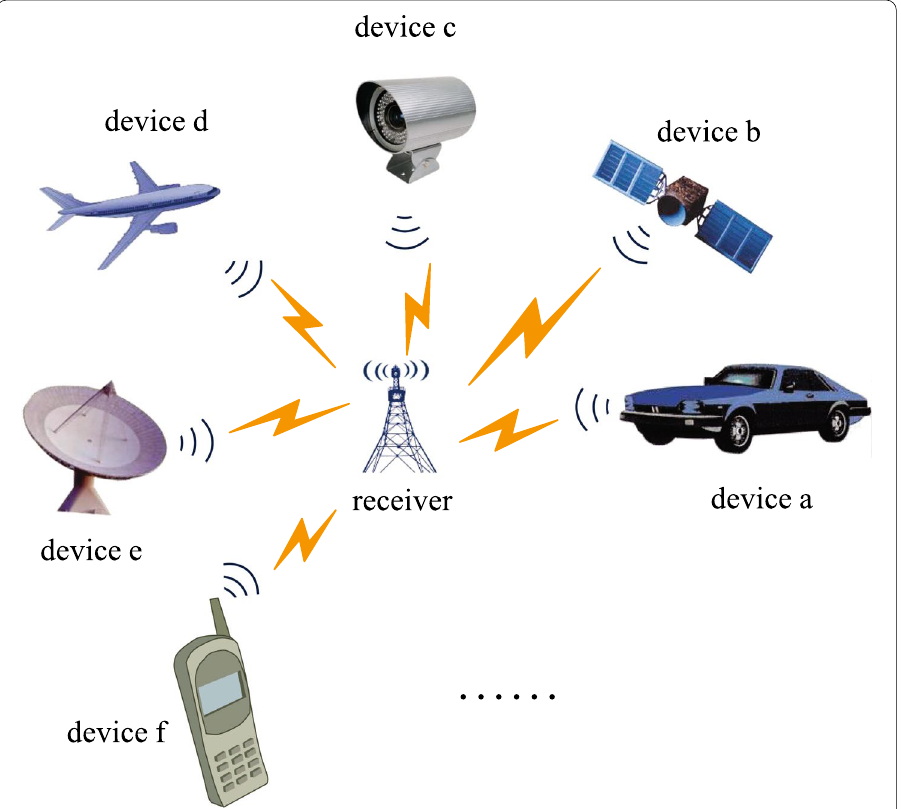
Fig. 1 AMC application scenarios in the Internet of